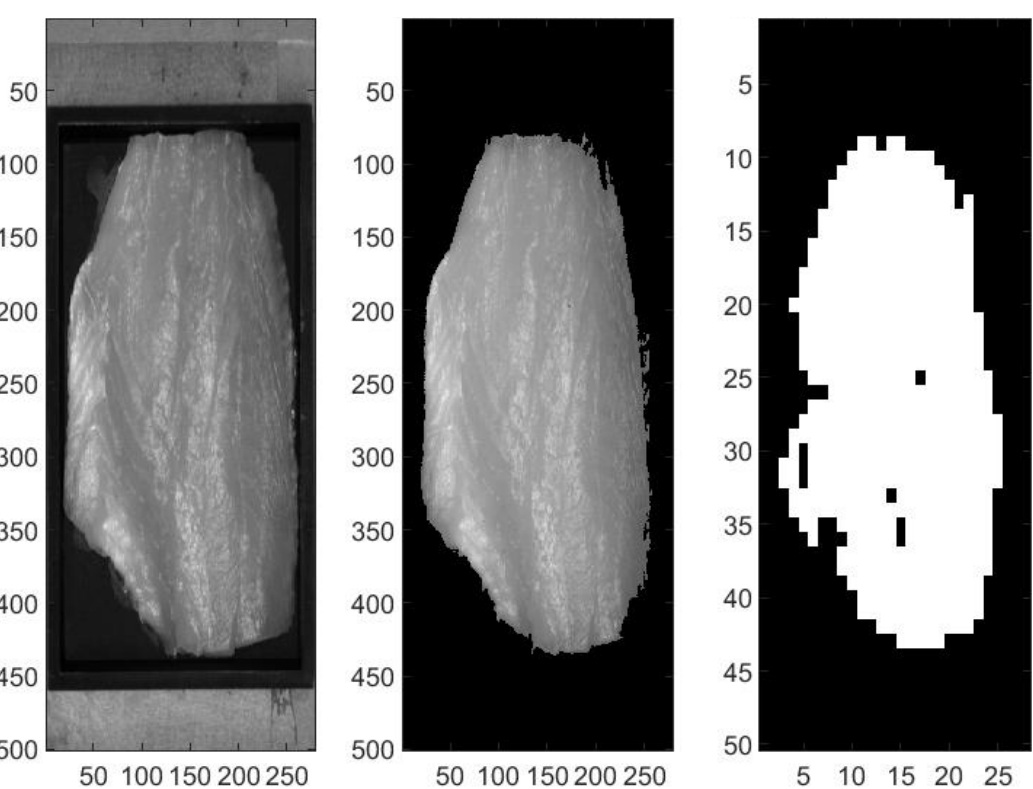
Figure 4. Example of data collection and voxel processing for a red snapper fillet. From the original VNIR image ( left ), a mask is applied ( center ) to remove the background and voxels of 10 × 10 pixels are generated ( right ). Valid voxels are shown in white.